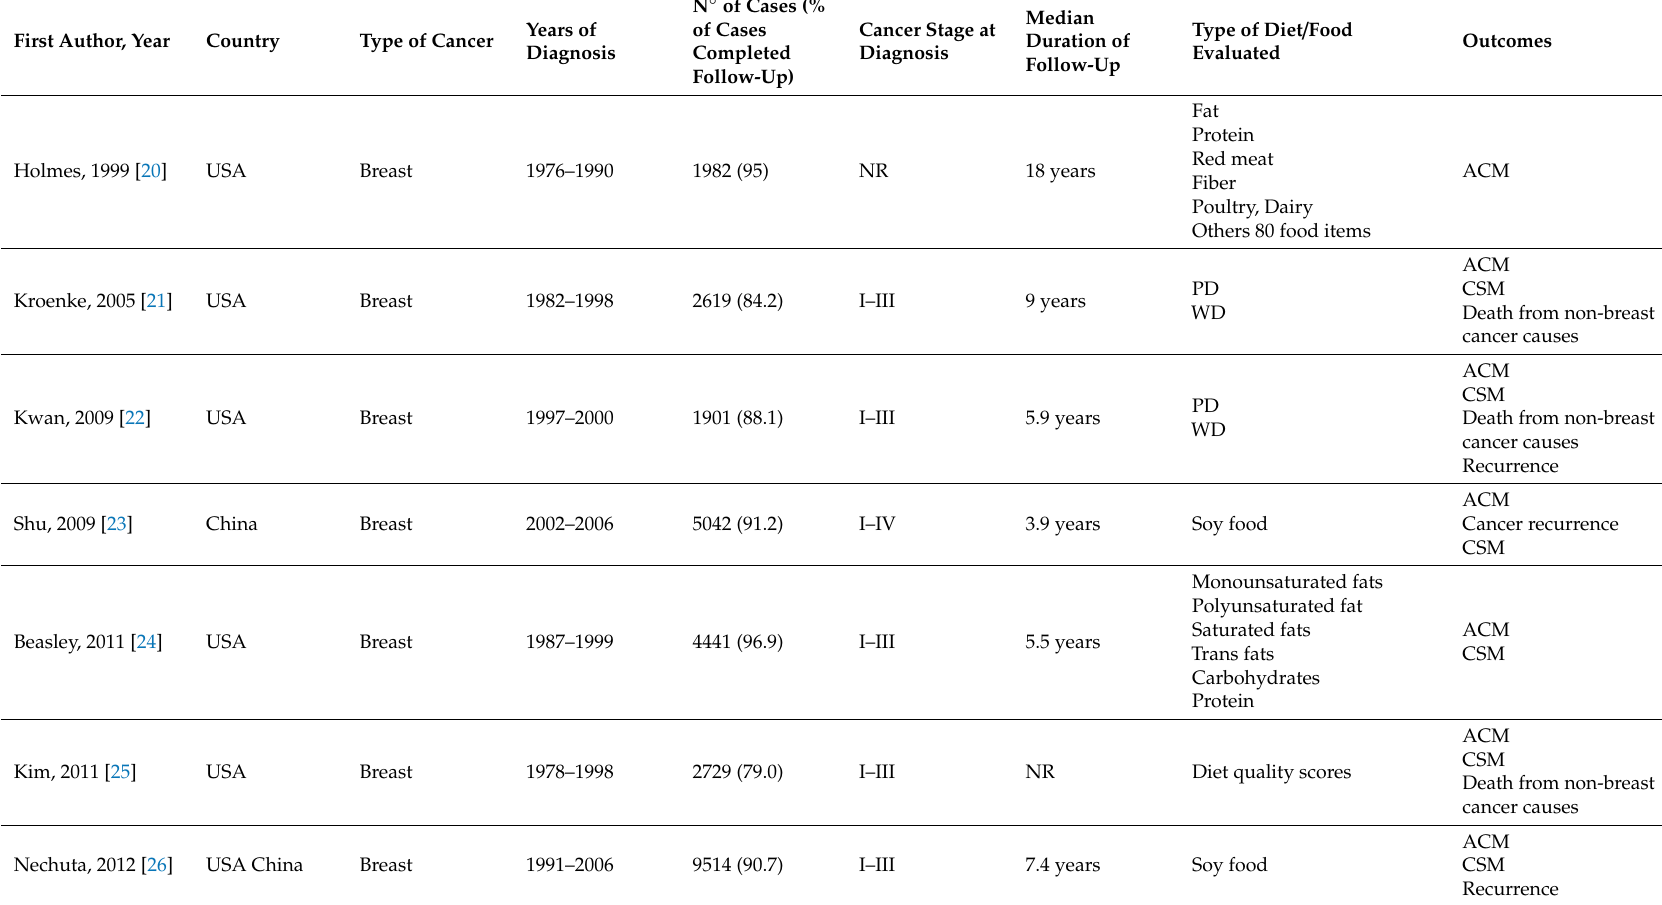
Table 1. Main characteristics of the included prospective